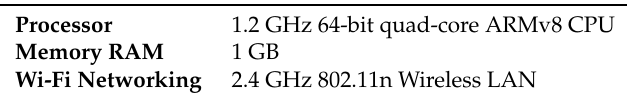
Table 2. Raspberry Pi 3 Model B